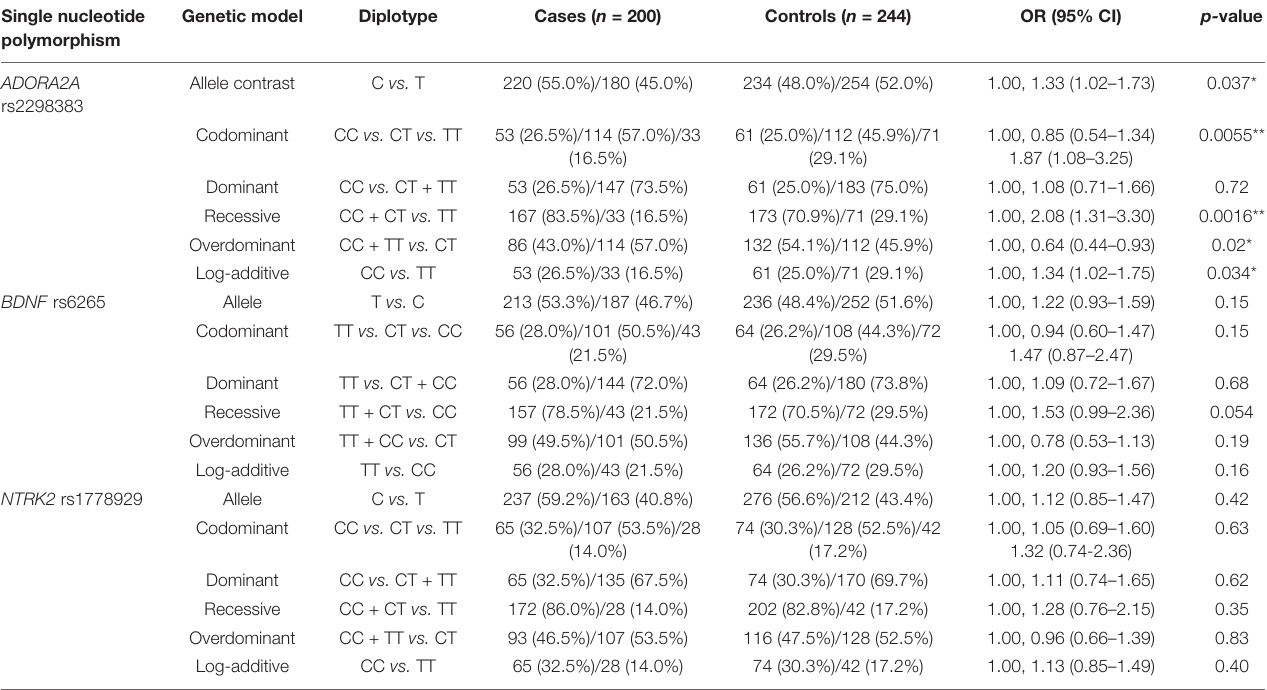
TABLE 2 | Comparison of ADORA2A rs2298383, BDNF rs6265, and NTRK2 rs1778929 diplotype distribution between healthy children and childhood epilepsy (CE) patients. Single nucleotide